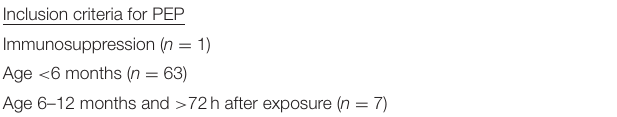
TABLE 1 | Inclusion criteria for measles post-exposure prophylaxis (PEP) and exclusion criteria for effectiveness analysis. Inclusion criteria for PEP